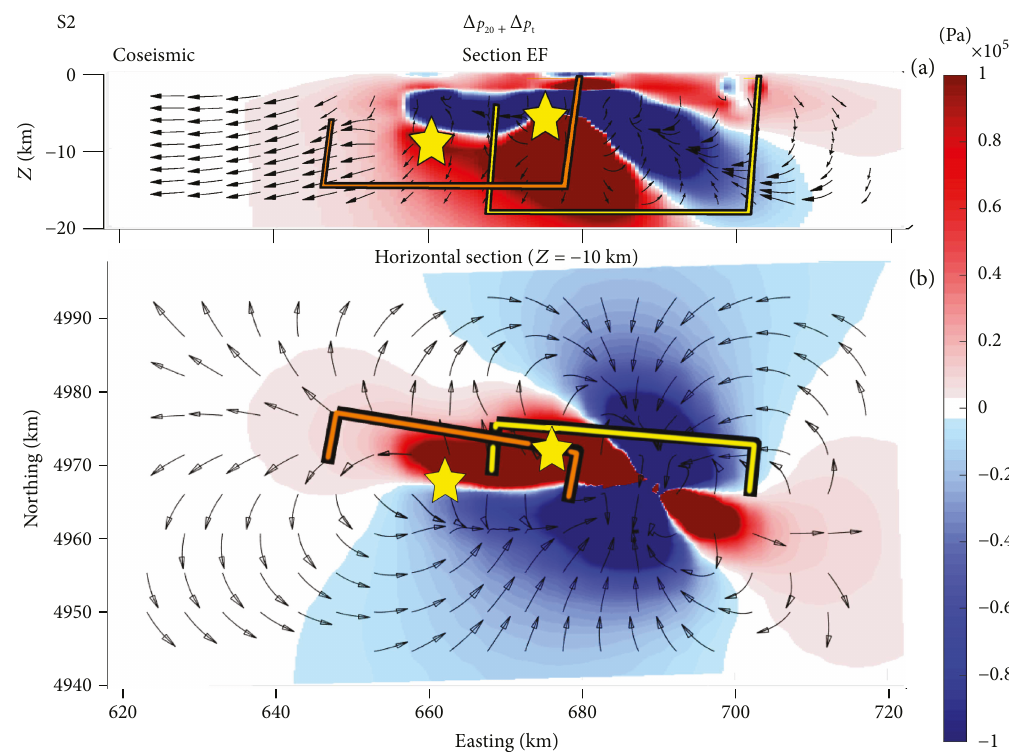
Figure 6: For scenario S2, coseismic pore-pressure distribution, Δ p at 10km depth (bottom panel). Yellow and orange lines: borders of the Ferrara and Mirandola faults emerging above the panels. Black arrows: fl uid fl ow streamlines (logarithmic scale). Stars represent the May 20 and May 29